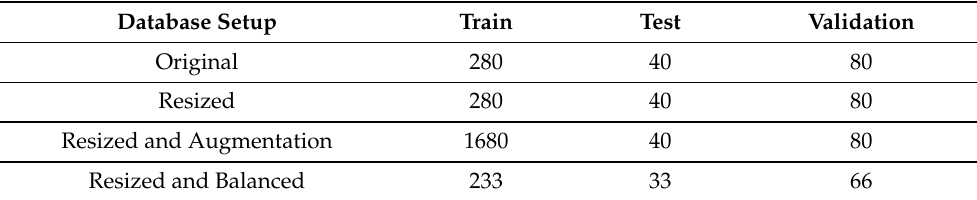
Table 2. Database setup distribution.